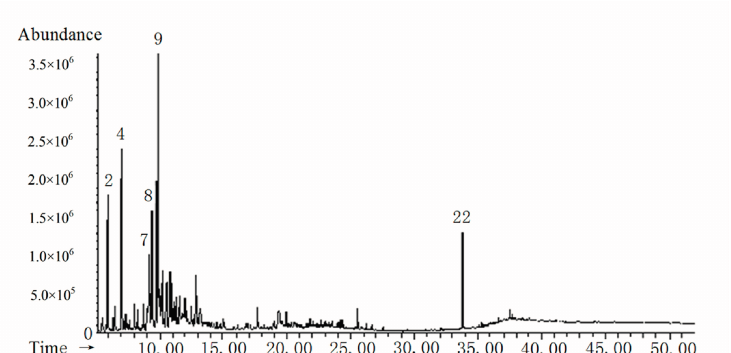
Figure 5. Total ion chromatogram and the main constituents of PA-200